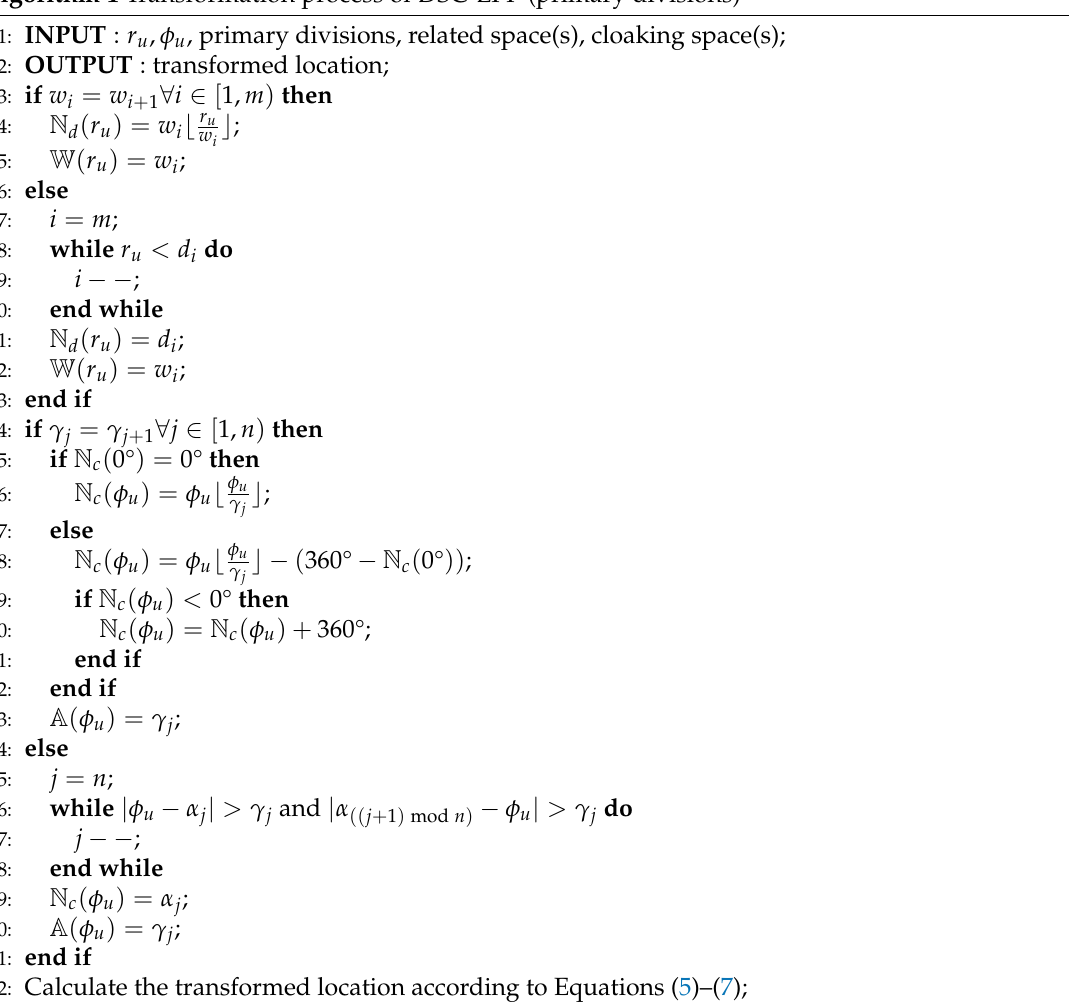
Algorithm 1 Transformation process of DSC-LPP (primary